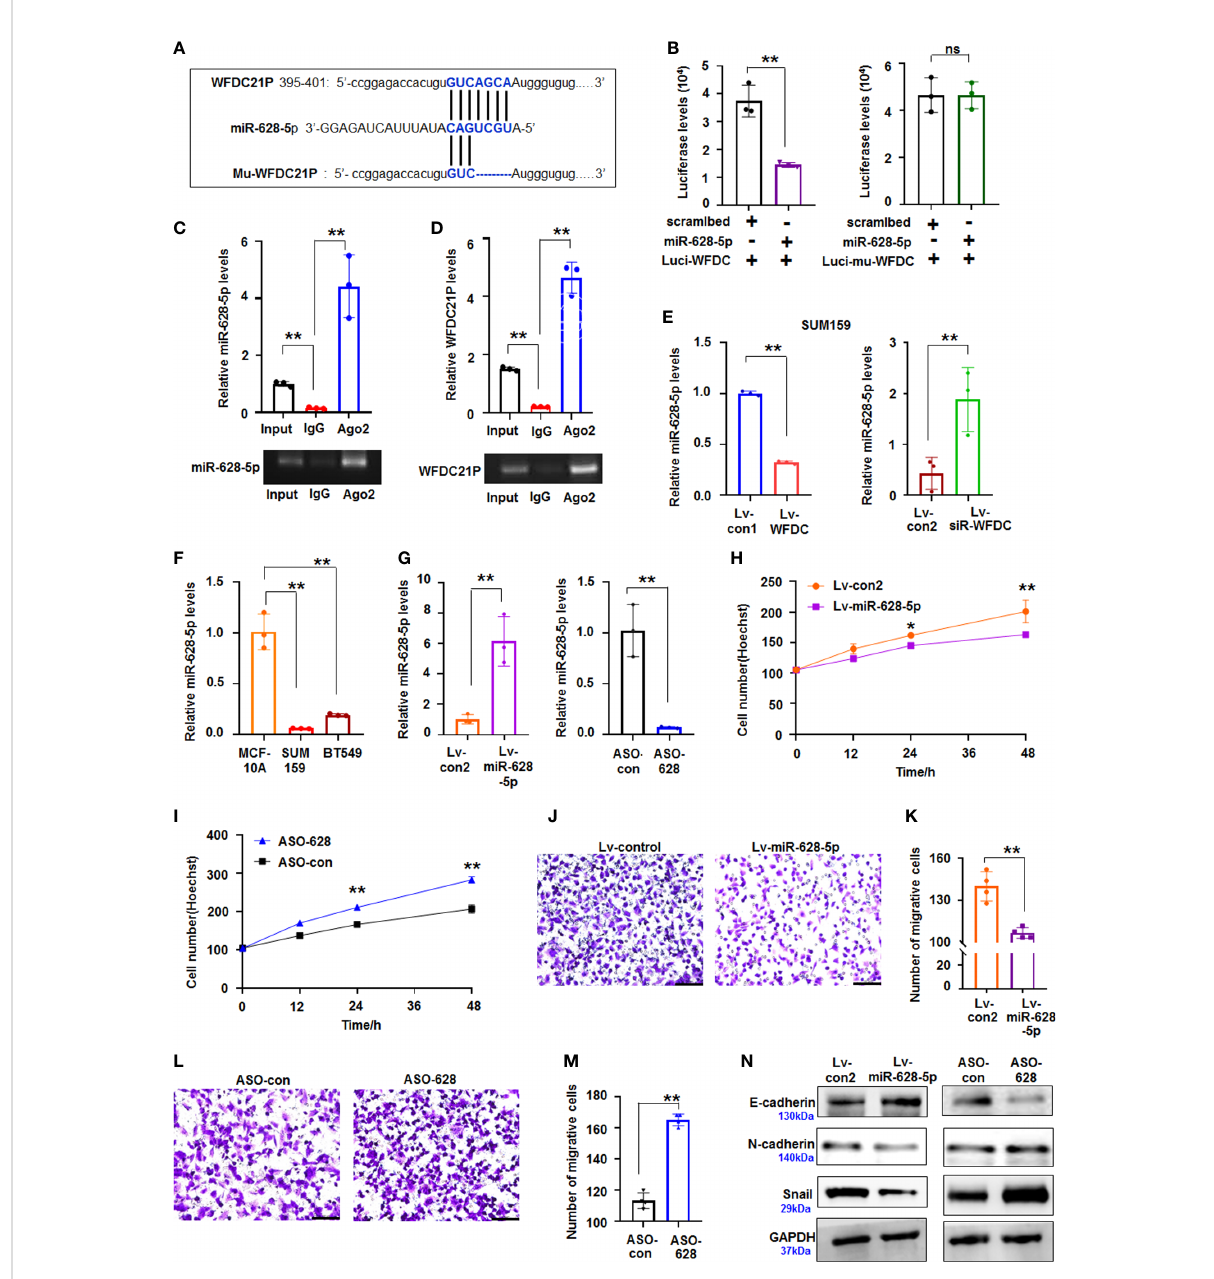
FIGURE 3 miR-628-5p was regulated by WFDC21P and inhibited TNBC proliferation and metastasis. (A) The site of WFDC21P or Mu-WFDC21P mRNA matched with miR-628-5p. (B) SUM159 cells were treated with pc3.1-luci-WFDC21P (or mu-luci-WFDC21P) and miR-628-5p or controls. Data are expressed as the mean ± SD of triplicate experiments. ** p < 0.01, Student ’ s t-test. ns means “ no signi fi cance". (C, D) RNA immunoprecipitation assays. Levels of miR-628-5p and WFDC21P were estimated using qRT-PCR, respectively. Data are expressed as the mean ± SD of triplicate experiments. ** p < 0.01, ANOVA. (E) WFDC21P overexpression or siRNA-WFDC21P affected miR-628-5p levels in SUM159 cells, respectively. Data are expressed as the mean ± SD of triplicate experiments. ** p < 0.01, Student ’ s t-test. (F) miR-628-5p levels were analzyed by qRT-PCR in SUM159, BT549, and MCF-10A cells. Data were expressed as mean ± SD for triplicate experiments. ** p < 0.01, ANOVA. (G) miR-628-5p expression was analyzed after SUM159 cells were treated with lv-miR-628-5p -expression virus or ASO-628 oligos. Data are expressed as the mean ± SD of triplicate experiments. ** p < 0.01, Student ’ s t-test. (H, I) Hoechst staining assay illustrated that miR-628-5p suppressed or ASO-628 promoted SUM159 cell proliferation. Data are expressed as the mean ± SD of triplicate experiments. * p < 0.05, ** p < 0.01; ANOVA. (J, K) miR-628-5p overexpression inhibited SUM159 cell metastasis. Data are expressed as the mean ± SD of triplicate experiments. ** p < 0.01; Student ’ s t-test. (L, M) ASO-628 promoted SUM159 cell metastasis. Data are expressed as mean ± SD of triplicate experiments. ** p < 0.01; Student ’ s t-test. (N) immunoblotting